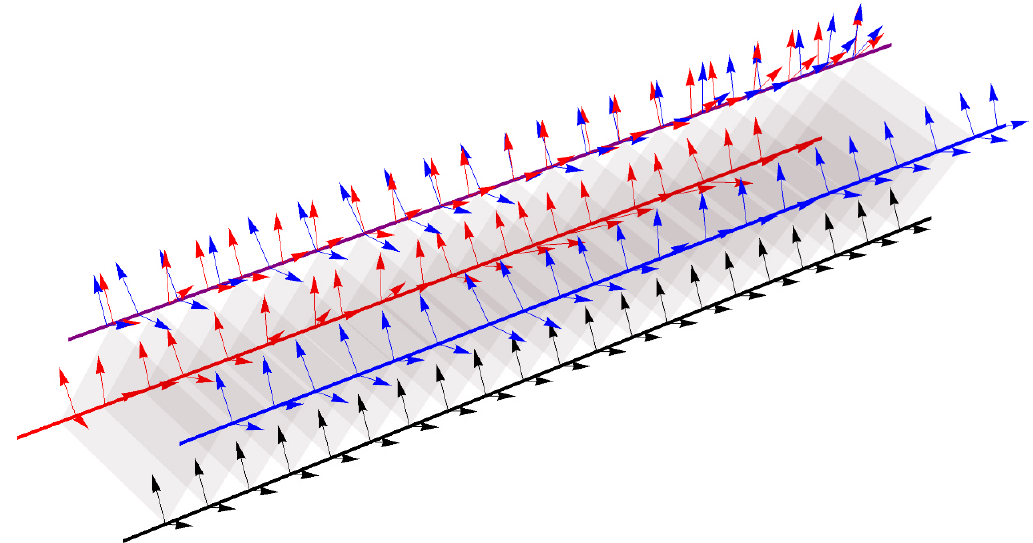
Figure 4 . Modular Berry curvature in the bulk. The modular zero mode frames are marked with pairs of arrows that stand for the normal vectors n M ( (cid:21); y ) (which transform under orthogonal (cid:11) boosts); the distances between neighboring pairs re(cid:13)ect the extremal surface di(cid:11)eomorphism frame. We parallel transport a zero mode frame from the bottom surface to the top surface along two di(cid:11)erent paths (red and blue); the mismatch between the resulting frames is the modular curva- ture. The mismatch between the locations of the red and blue arrows on the top is the surface di(cid:11)eomorphism component of the curvature (3.17) while the mismatch between their directions is the boost component of the curvature